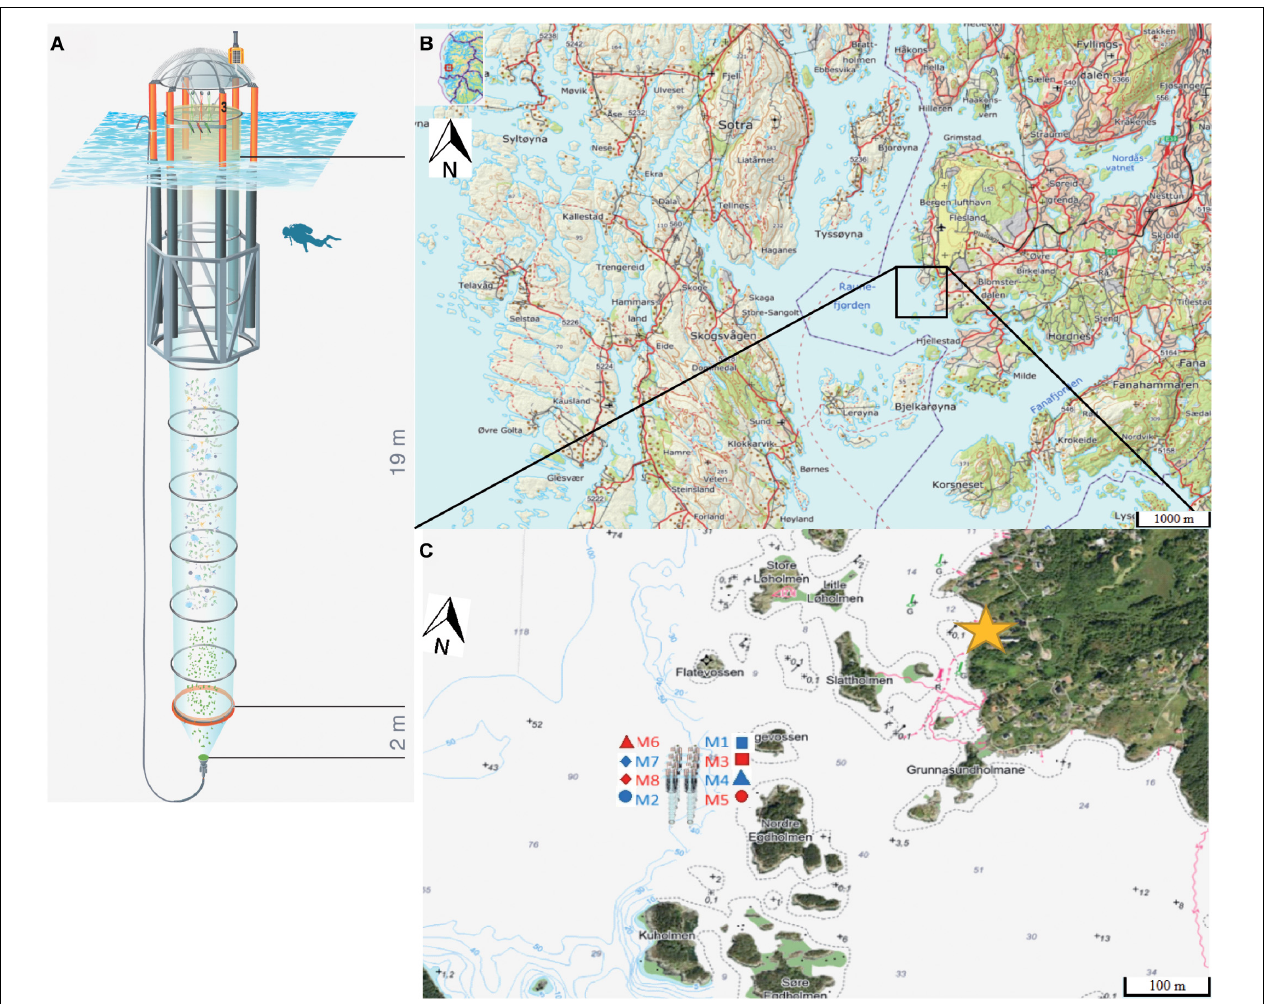
FIGURE 1 | (A) Kiel Off-Shore Mesocosm for Ocean Simulations (KOSMOS), a pelagic mesocosm system. Blue corrugated area represents water surface. Diver for scale. Illustration of the KOSMOS unit by Rita Erven (GEOMAR), reprinted with permission from the AGU. (B) Location of Raunefjord between the island Sotra (left) and the city of Bergen (right). Black square indicates deployment area of the mesocosms. (C) Position, order and corresponding symbols of the mesocosms in their deployment area in front of the Espegrend Marine Research Field Station (marked by the yellow star), Bergen (not to scale). Red mesocosm numbers indicate high p CO 2 treatments, blue ones the control treatment. (B,C) Map modified after: The Norwegian Mapping Authority (Kartverket, accessed 7th July 2020, http://geo.ngu.no/kart/arealisNGU/). Figure assembled and designed with Adobe Illustrator CS4 (Adobe-Inc,